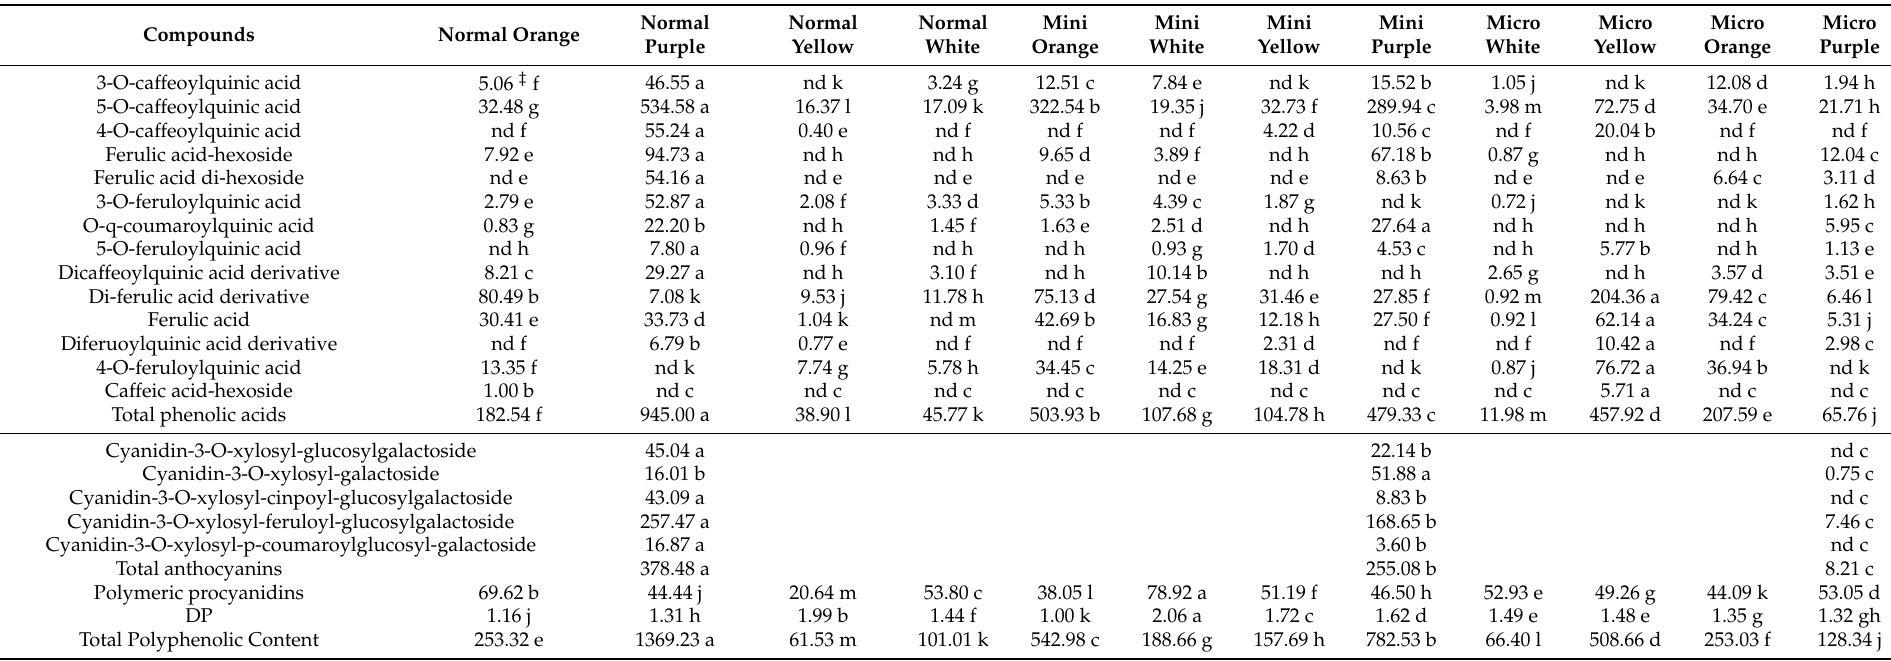
Table 2. Quantifications of phenolic compounds in 12 carrot